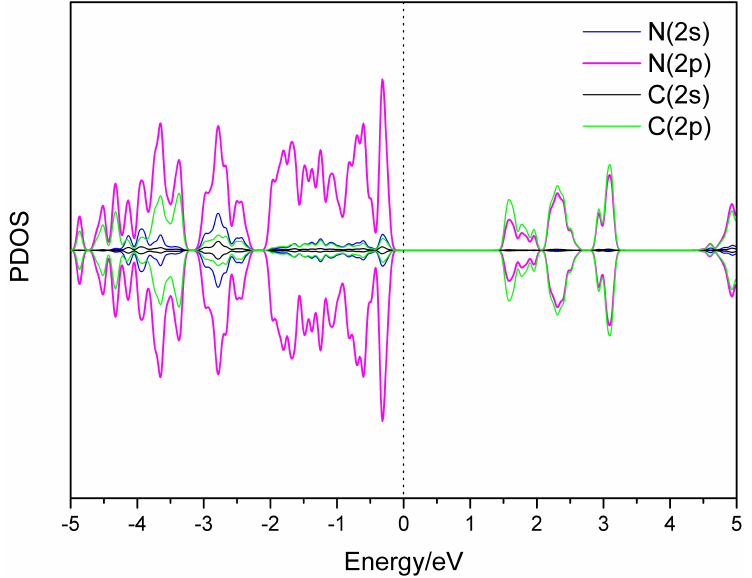
Figure 2. The partial density of states (PDOS) of the g-C The energy was plotted with respect to the Fermi